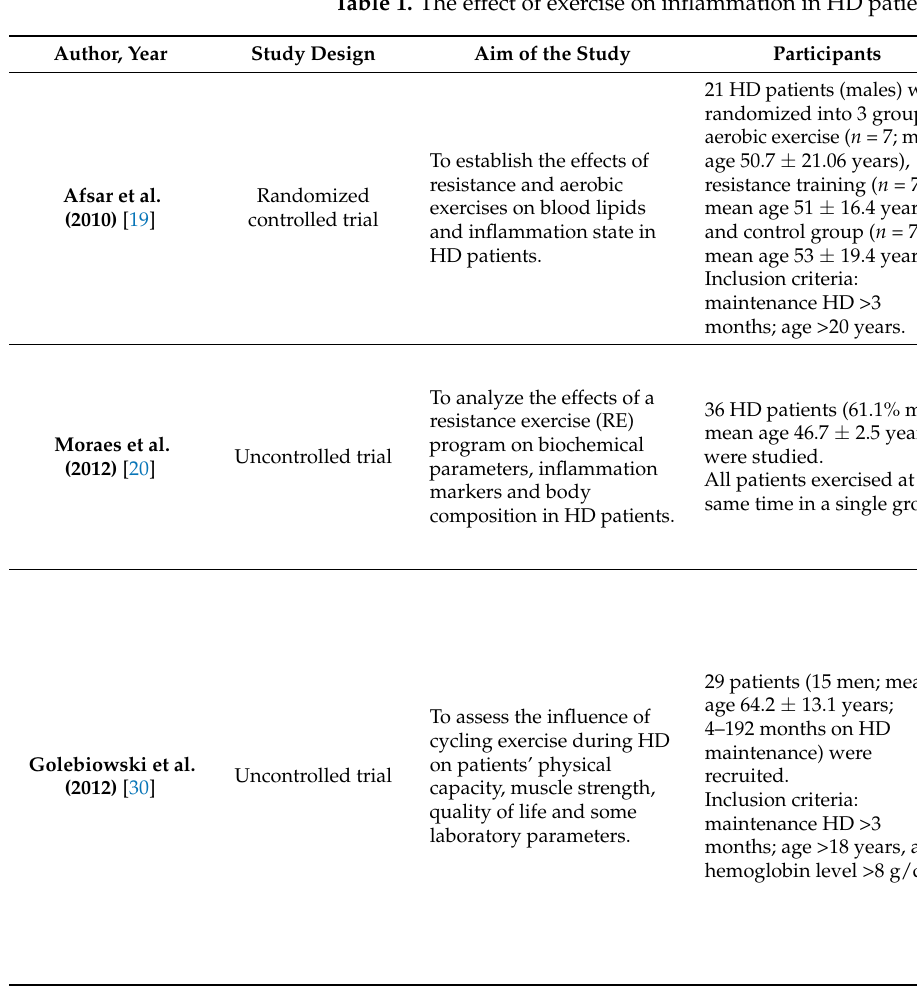
Table 1. The effect of exercise on inflammation in HD